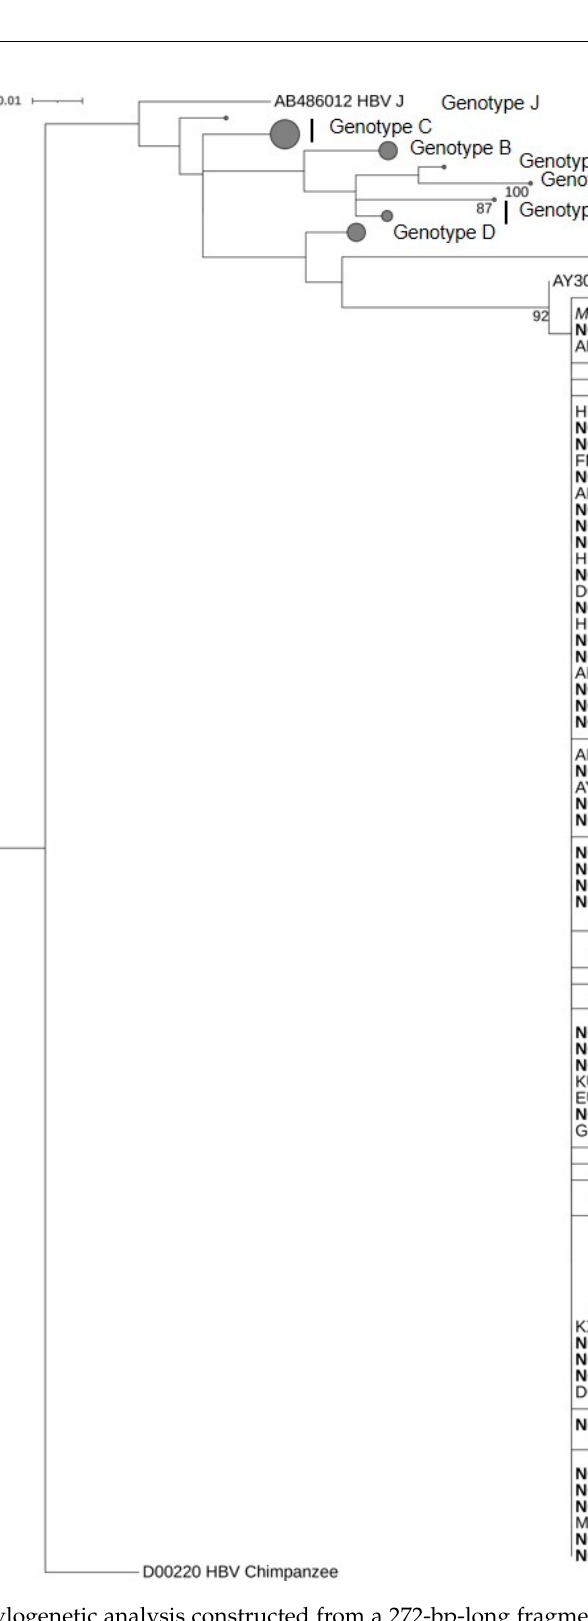
Figure 1. Phylogenetic analysis constructed from a 272-bp-long fragment of the HBs gene of HBV using the maximum likelihood method based on the TVM+I+G4 model. All 42 sequences clustered within genotype E. The HBV sequences from this study are indicated in bold characters. The best BLASTn matches are presented in italics. HBV reference genomes of genotypes A–D and F–J are collapsed with the size of the gray circles being proportional to the number of reference sequences. Bootstrap values >75% are indicated.